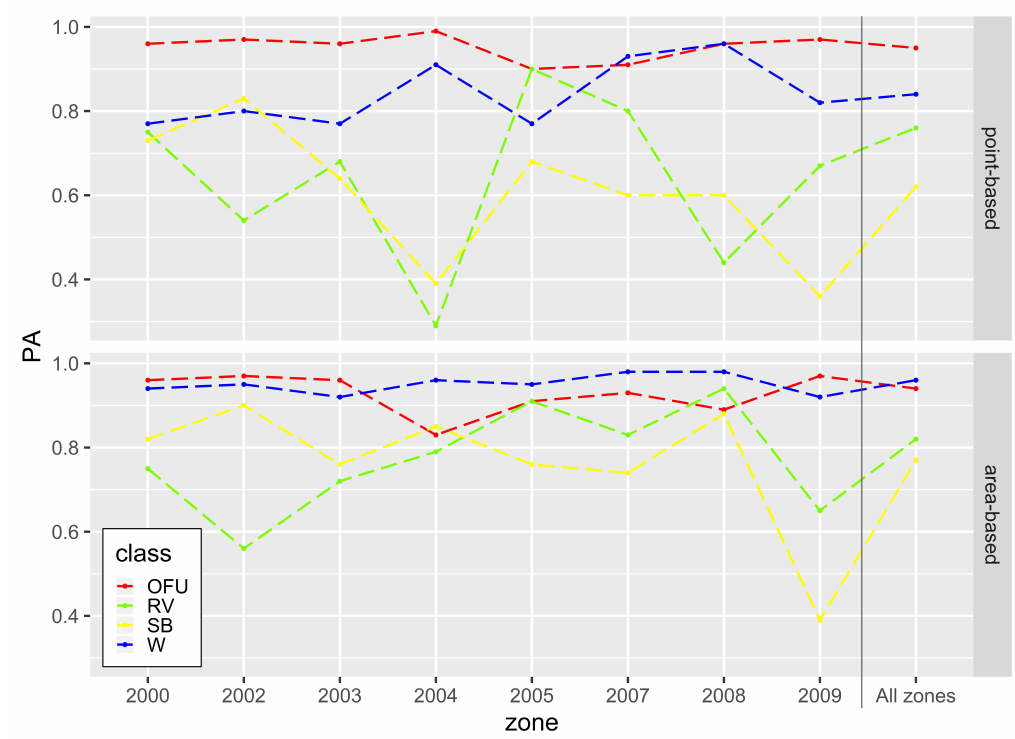
Figure 14. Per-class producer accuracy (PA) values for the point-based and area-based assessments divided by zone of analysis.